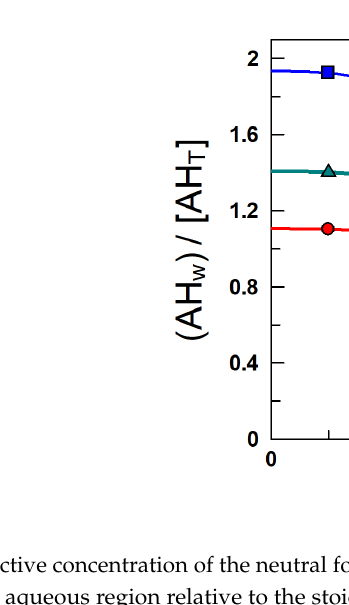
to the stoichiometric concentration.